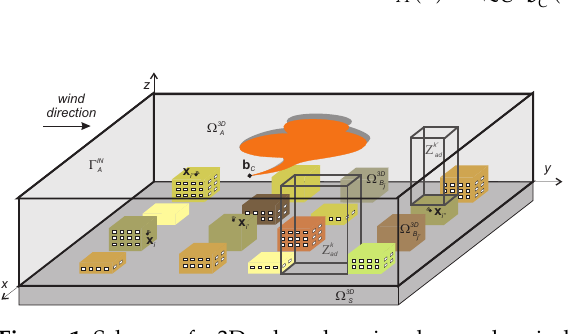
Figure1. Schemeofa3Durbandomainwhereachemicalincidentoccursatpoint b C . Figure 1. Scheme of a 3D urban domain where a chemical incident occurs at point b C